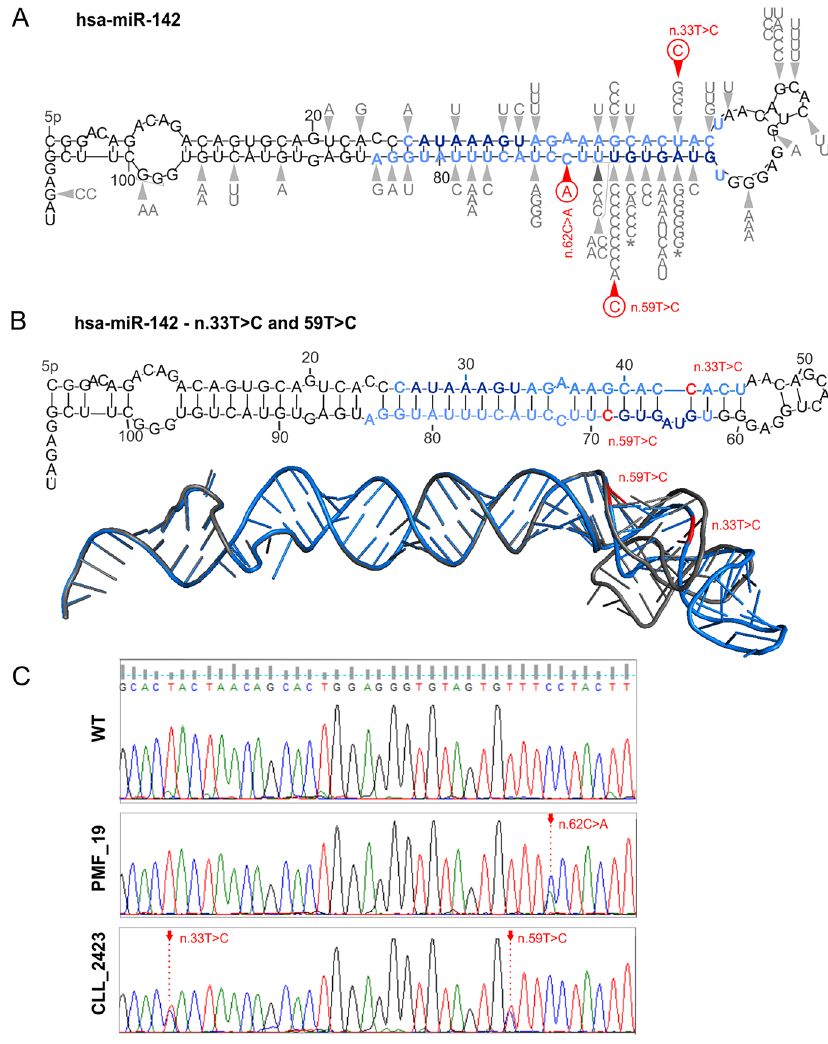
Figure 1. Characteristics of the MIR142 mutations detected in this study. ( A ) Locations of the mutations on the secondary stem-loop structure (predicted with mfold 37 ) of the wild-type miR-142 precursor. Blue font indicates miRNA duplex, dark blue indicates seed regions, and black indicates flanking regions and terminal loop. Gray symbols represent mutations identified before (based on 4 ), and red-circled symbols indicate mutations identified in this study. ( B ) Secondary (above) and 3D (below) RNA structures adopted by the n.33T>C and n.59T>C mutant found in CLL. The 3D mutant structure (blue) is aligned with the corresponding wild-type structure (black). The mutations are indicated in red. The 3D structures were generated using RNAComposer 38 and visualized in PyMOL (Schrödinger, LLC, New York, NY, USA). ( C ) Sanger sequencing results for wild-type and mutated